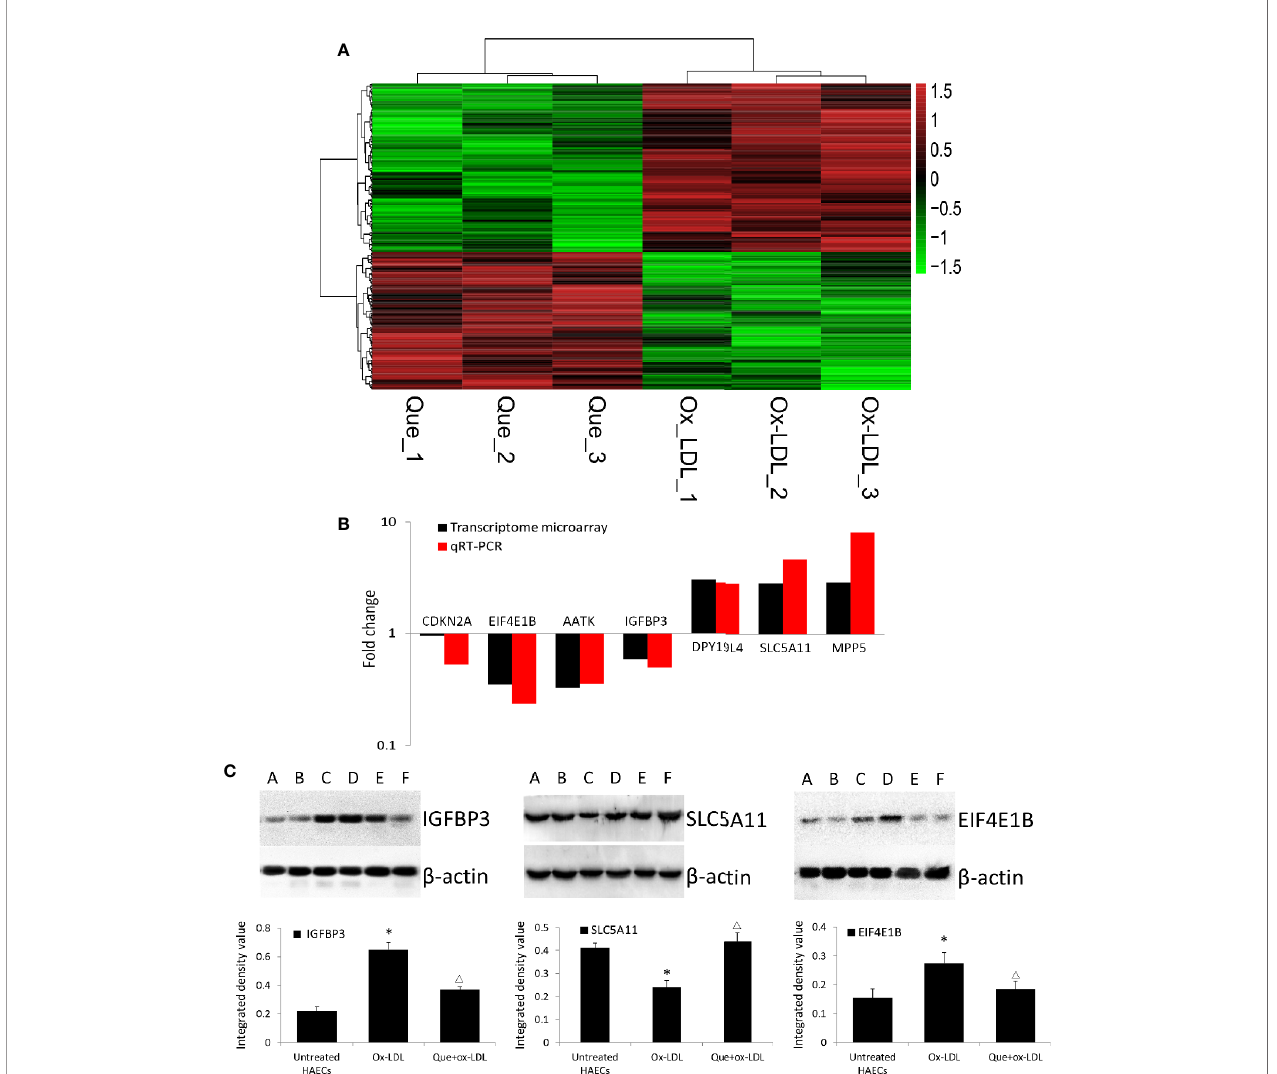
FIGURE 4 | Heatmap of differentially expressed (DE) mRNAs in transcriptome microarray and q-PCR and Western blotting veri fi cation. (A) Heatmap of DE mRNAs in transcriptome microarray (n = 3). Human aortic endothelial cells (HAECs) were cultured for 48 h in the presence of 50 m g/mL ox-LDL, or 50 m g/mL ox-LDL followed with quercetin at optimum concentration (3 m mol/L). In total, 254 DE mRNAs (110 mRNAs were upregulated and 144 mRNAs were downregulated) were identi fi ed (fold change > 1.5, P < 0.05, Que vs Ox-LDL). Black stands for 0, meaning no difference between groups. Red stands for high expression, while green represents low expression. (B) q-PCR (n = 6) veri fi cation DE mRNAs compared to microarrays. (C) Western blotting assay and integrated density analysis veri fi ed the DE protein expression level of EIF4E1B, IGFBP3 and SLC5A11. A and B: Untreated HAECs; C and D: Ox-LDL treated HAECs; E and F; ox-LDL treatment followed with 3 mmol/L quercetin. *P < 0.05, vs untreated HAECs; Δ P < 0.05, vs ox-LDL; n =